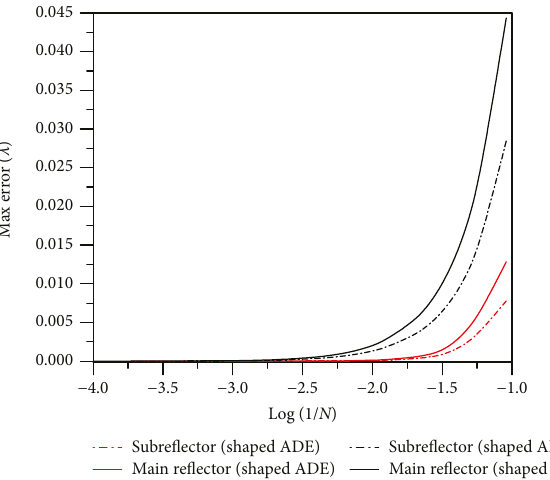
Figure 18: Maximum error of shaped ADE and ADC antennas ′ ) as a function of N ( − 30 dB attenuation at x U